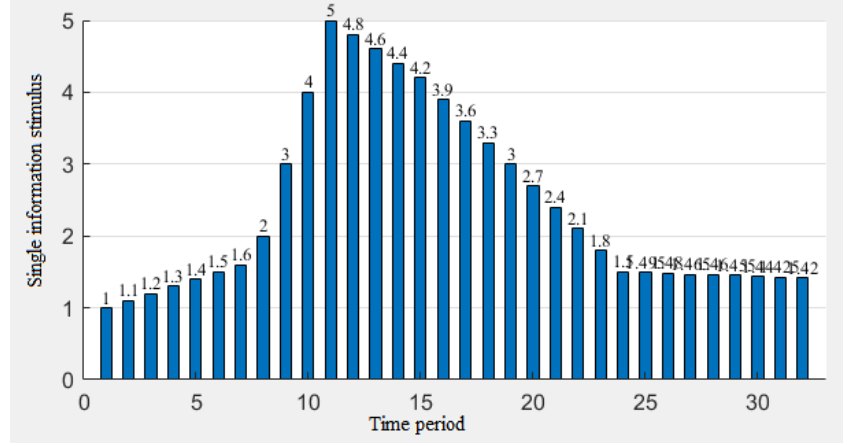
Figure 11. Assignment of the information stimulus from 27 December 2019 to 2 May 2020.